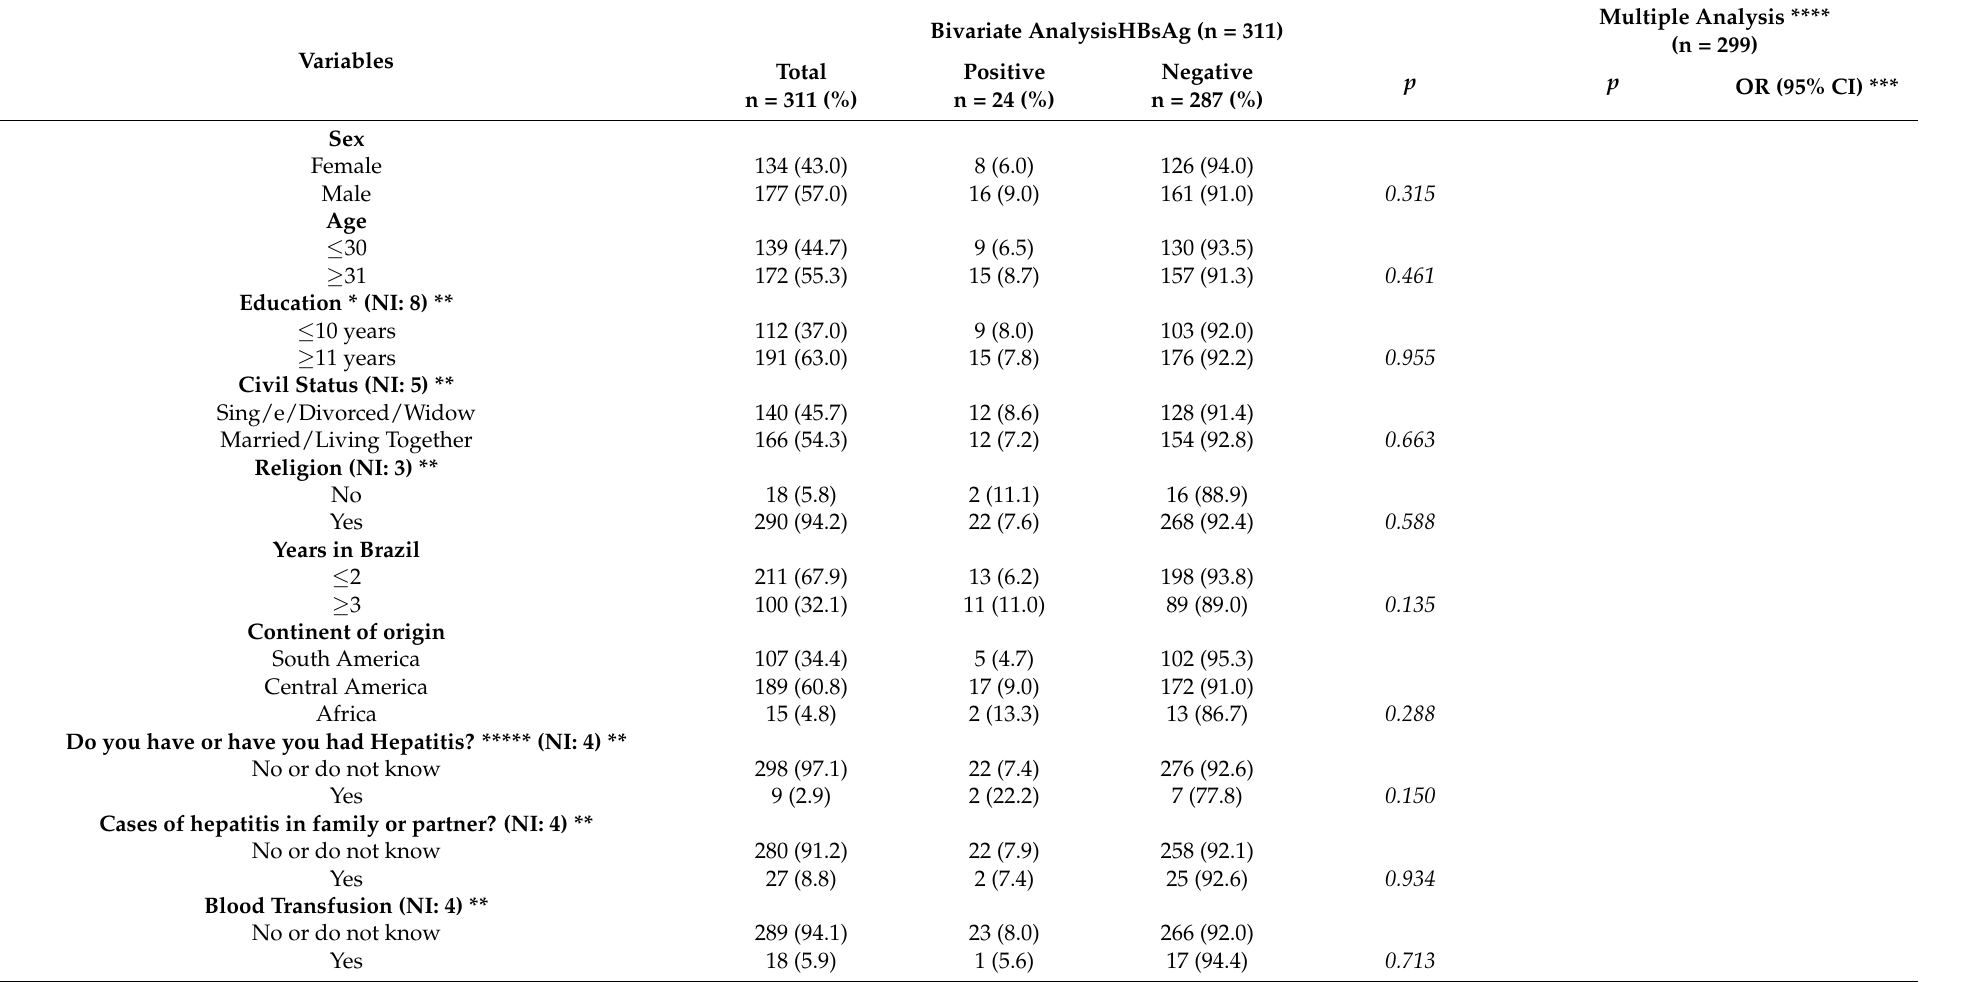
Table 3. Bivariate and multiple analysis of sociodemographic characteristics, immigration, and factors associated with HBsAg positivity in 311 foreign immigrants from the State of Goi á s,